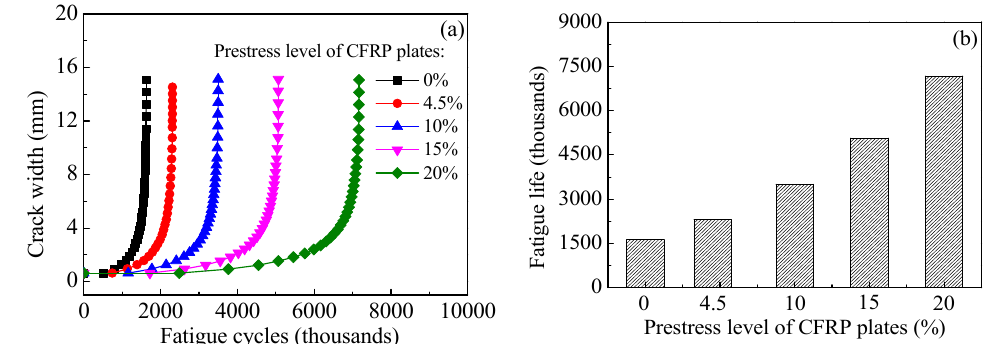
Figure 26. Effect of prestress level of CFRP plate on ( a ) the crack propagation curves and ( b ) the fatigue life of the corroded steel plate strengthened with CFRP plates.